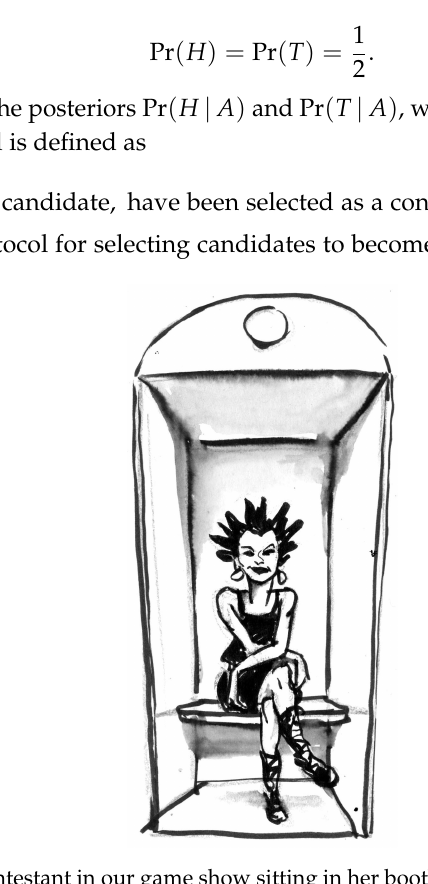
Figure 2. A potential contestant in our game show sitting in her booth, contemplating what to do when chosen as an actual contestant (drawing by Laurent